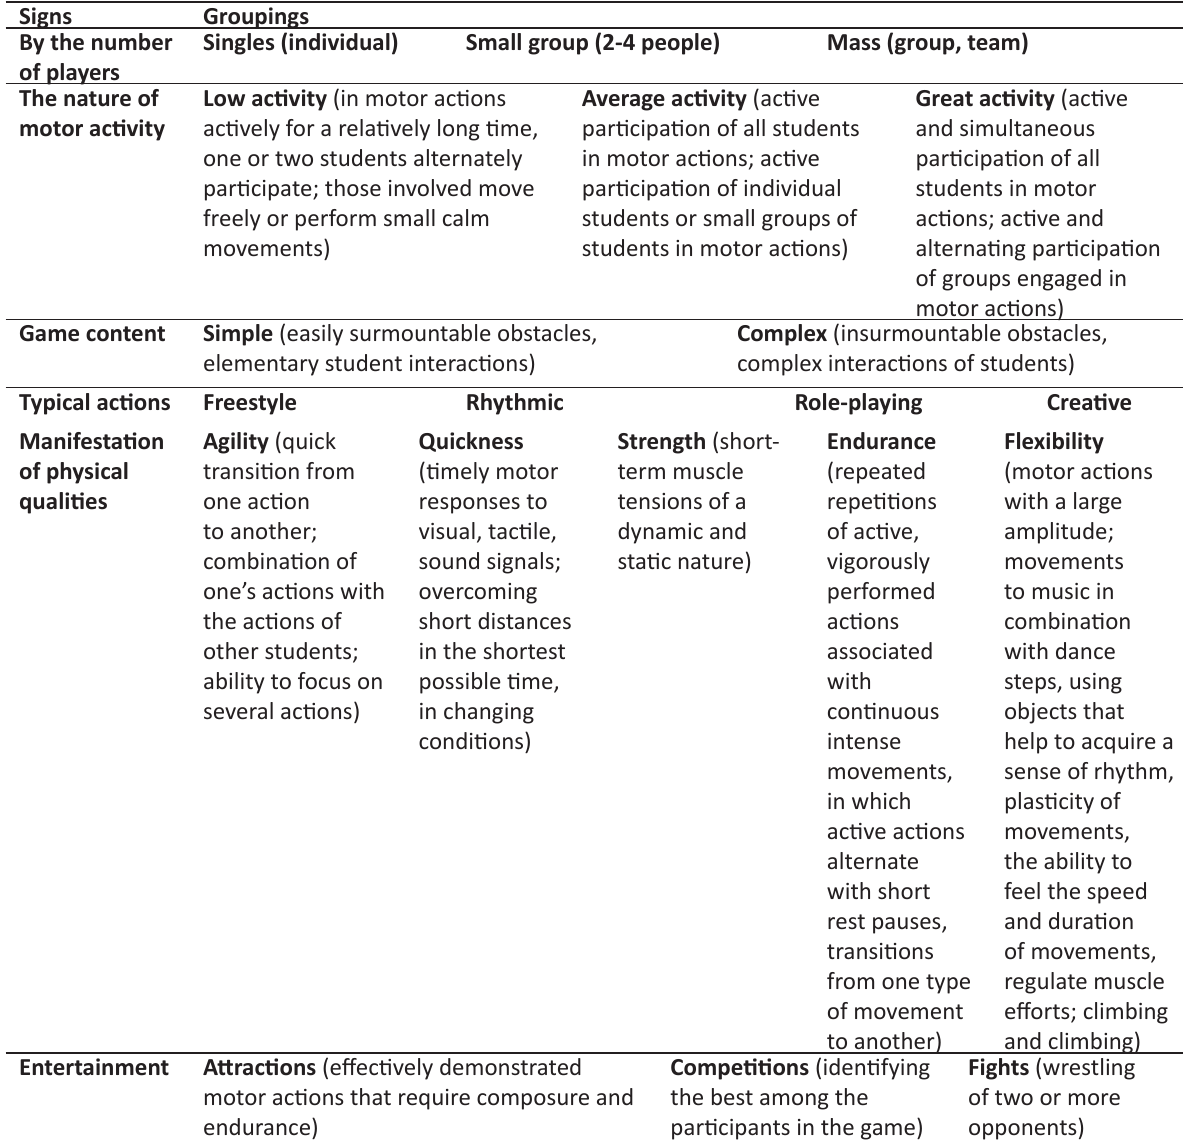
Table 1. Classification of game activities of students Signs The nature of